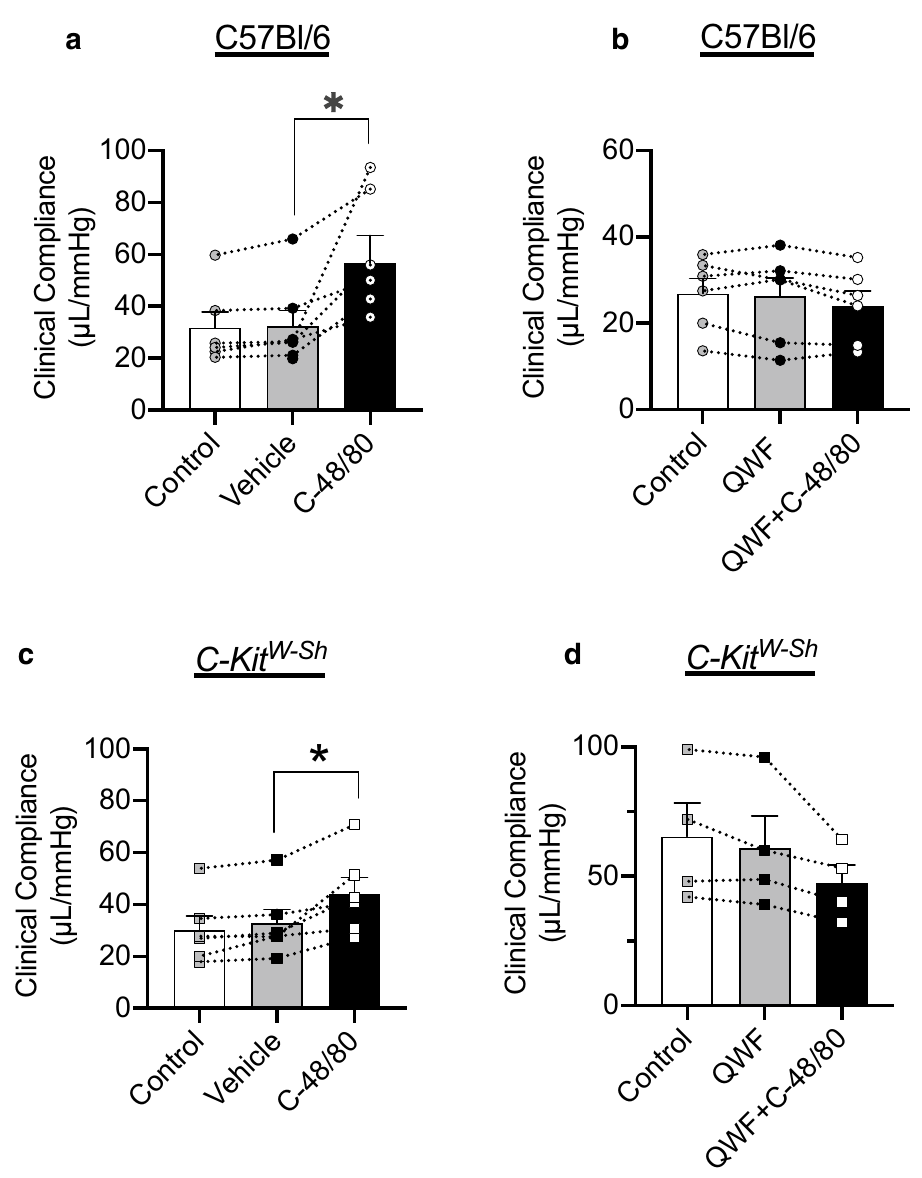
Figure 5. Compound 48/80 significantly increases clinical compliance independent of mast cell activation. ( a , c ) Clinical compliance was increased after exposure to 10 µg/mL Compound 48/80 in both C57Bl/6 ( P = 0.01; N = 6, C-48/80 vs . Vehicle) and C-kit W-Sh mice ( P = 0.034; N = 6, C-48/80 vs. Vehicle). ( b , d ) this increase was blocked by 10 µM QWF in both C57Bl/6 (P = 0.206; N = 6, QWF vs. QWF + C-48/80) and C-kit W-Sh